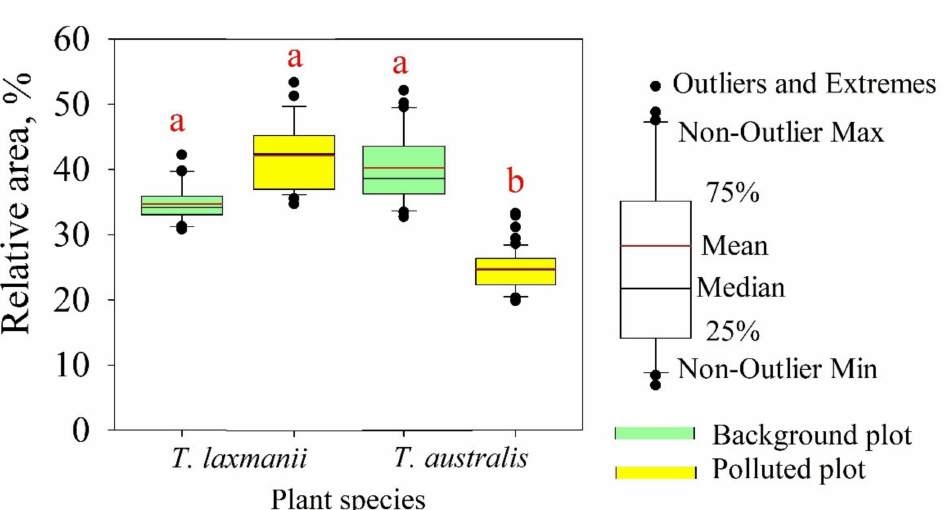
Figure 8. Relative area of parenchyma on the cross-section of the leaf of T. australis and T. laxmannii growing in the back- ground and polluted plots. Different letters indicate significant differences ( p < 0.05) resulting from the post hoc Tukey’s HSD